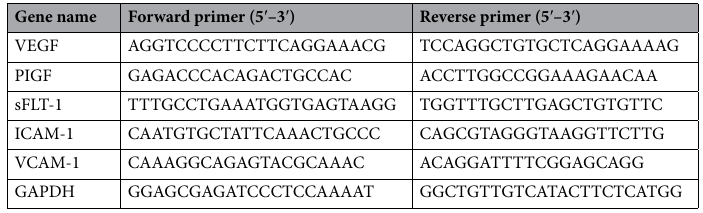
Table 1. Primer sequence for qRT-PCR.